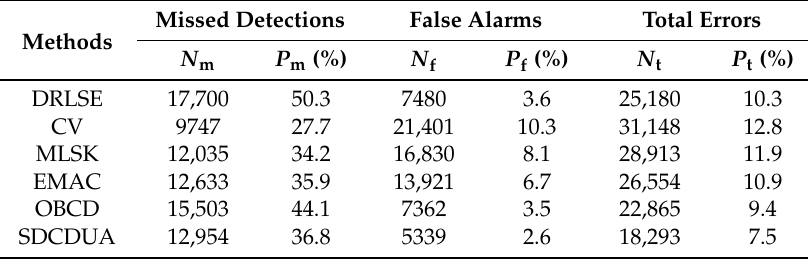
Table 6. Quantitative comparison between the comparative and proposed methods for data set